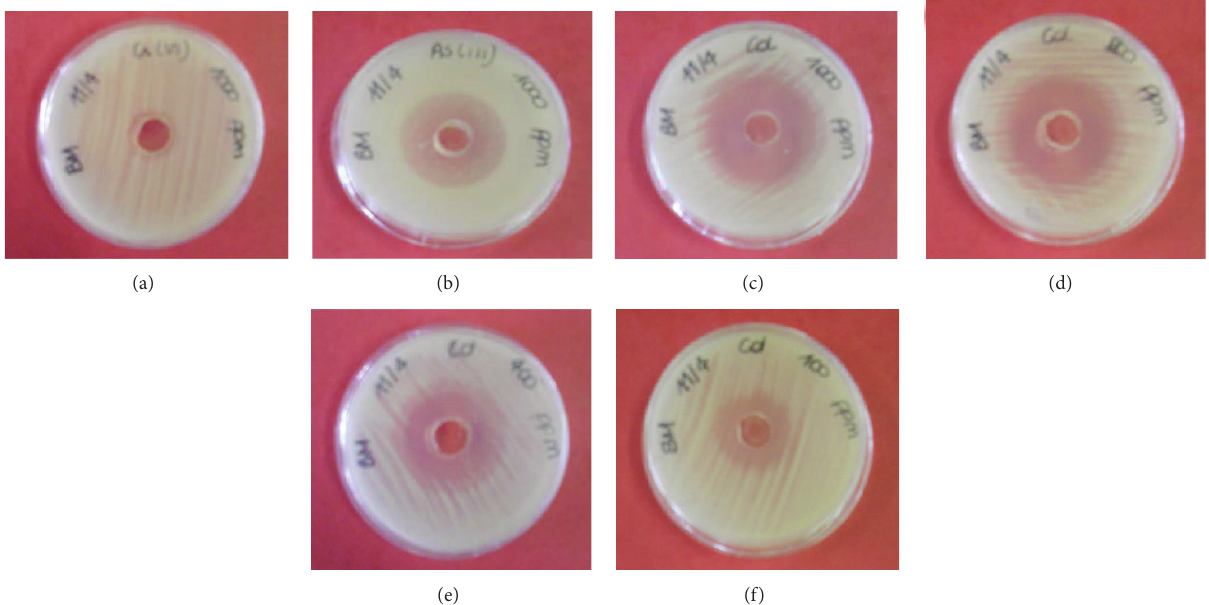
Figure 1: Visualization of the inhibition zones in the plate diffusion test for the investigation of the effect of (a) 1000 ppm (19.23 mM) Cr(VI), (b) 1000ppm (13.35 mM) As(III), (c) 1000 ppm (8.90 mM) Cd(II), (d) 800 ppm (7.12mM) Cd(II), (e) 400 ppm (3.56 mM) Cd(II), and (f) 100ppm (0.89 mM) Cd(II) on the growth of Bacillus mucilaginosus .